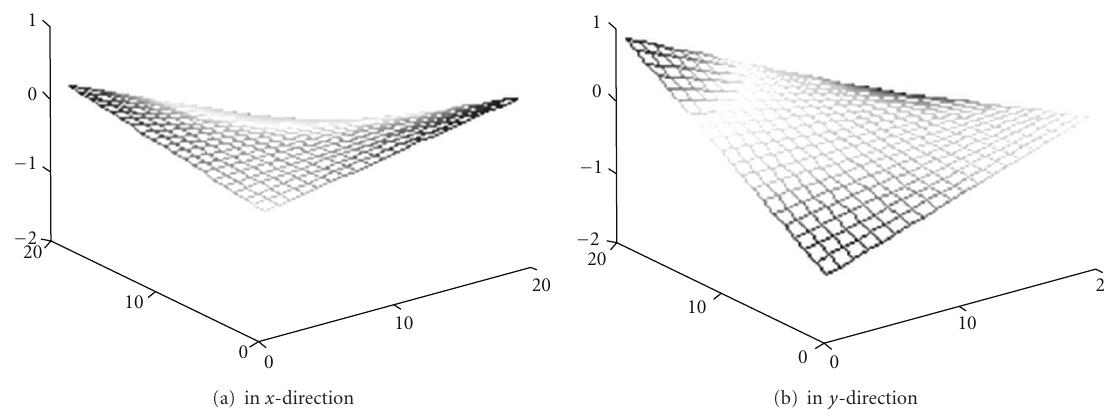
Figure 3: Error surfaces in x - and y -directions on a